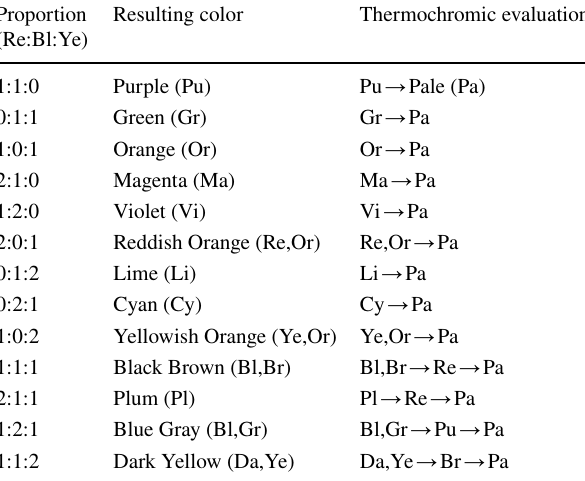
Table 1 The colors that can be modulated through the mixing of the water-based red, blue, and yellow inks with a transition temperature of 43 °C and their associated thermochromic evaluation Proportion Resulting color Thermochromic (Re:Bl:Ye)